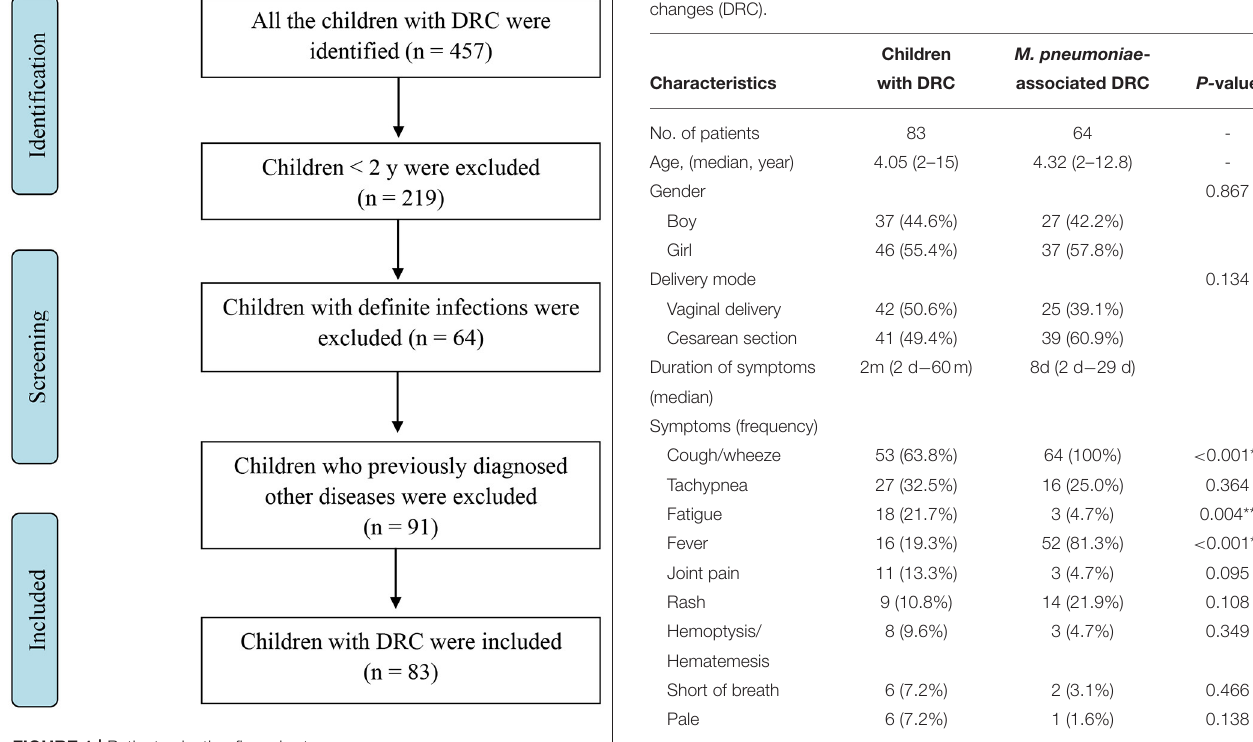
FIGURE 1 | Patient selection flow chart.